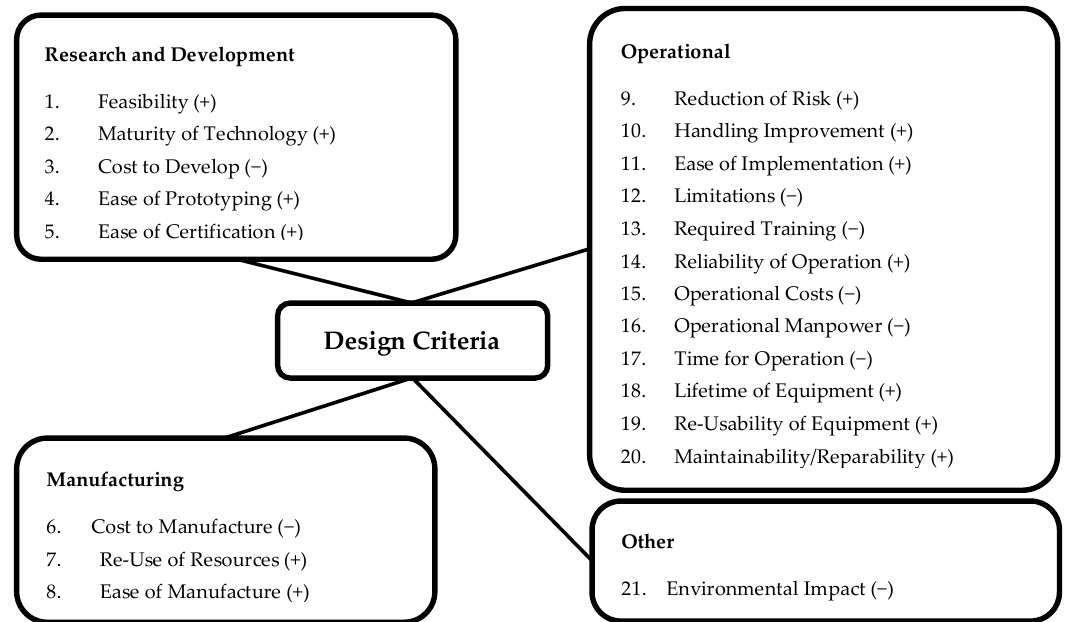
Figure 6. Criteria to be considered (+/ − indicate positive/negative variables).